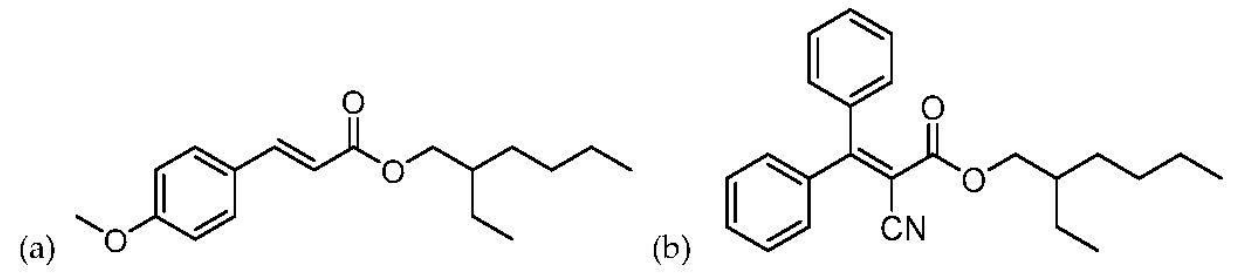
Figure 1. The chemical structures of octinoxate (INCI: Ethylhexyl methoxycinnamate) ( a ) and octo- crylene ( b ).